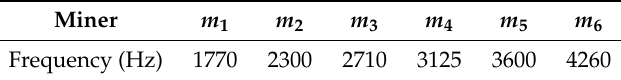
Table 1. Six selected frequencies representing